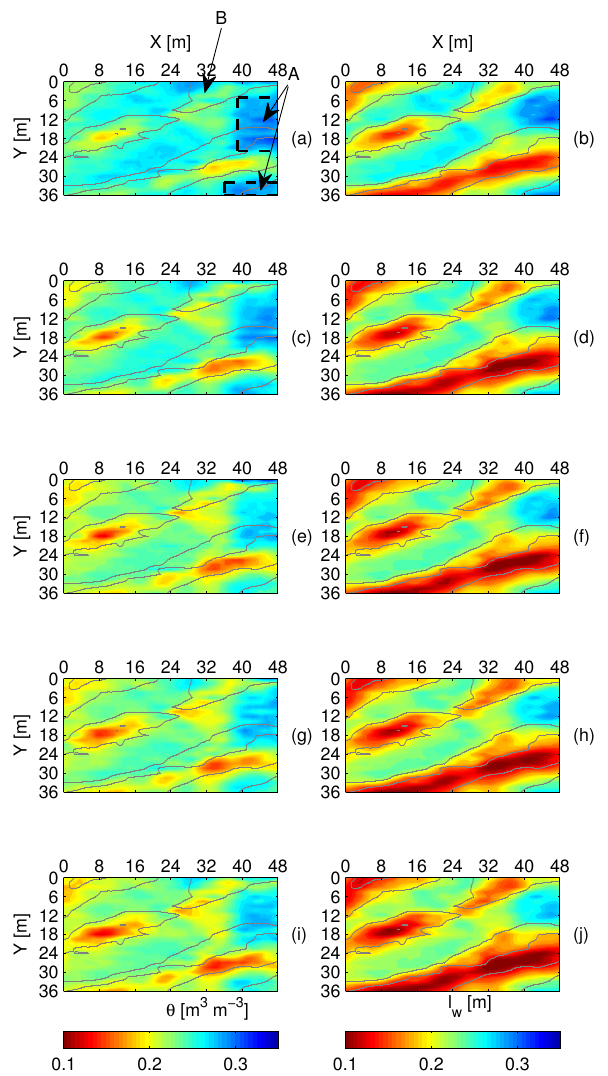
Fig. 5. Time-lapse images of depth-averaged soil water content θ , and total water volume l w between surface and the dune interface on 22, 23, 25, 27, 29 May 2011 (from top to bottom panels). Grey contour lines in all images represent the dune structure with a con- tour interval of 0.2m. Blocks A are the areas with clay inclusions over the dune structure, and the other area is marked as B.